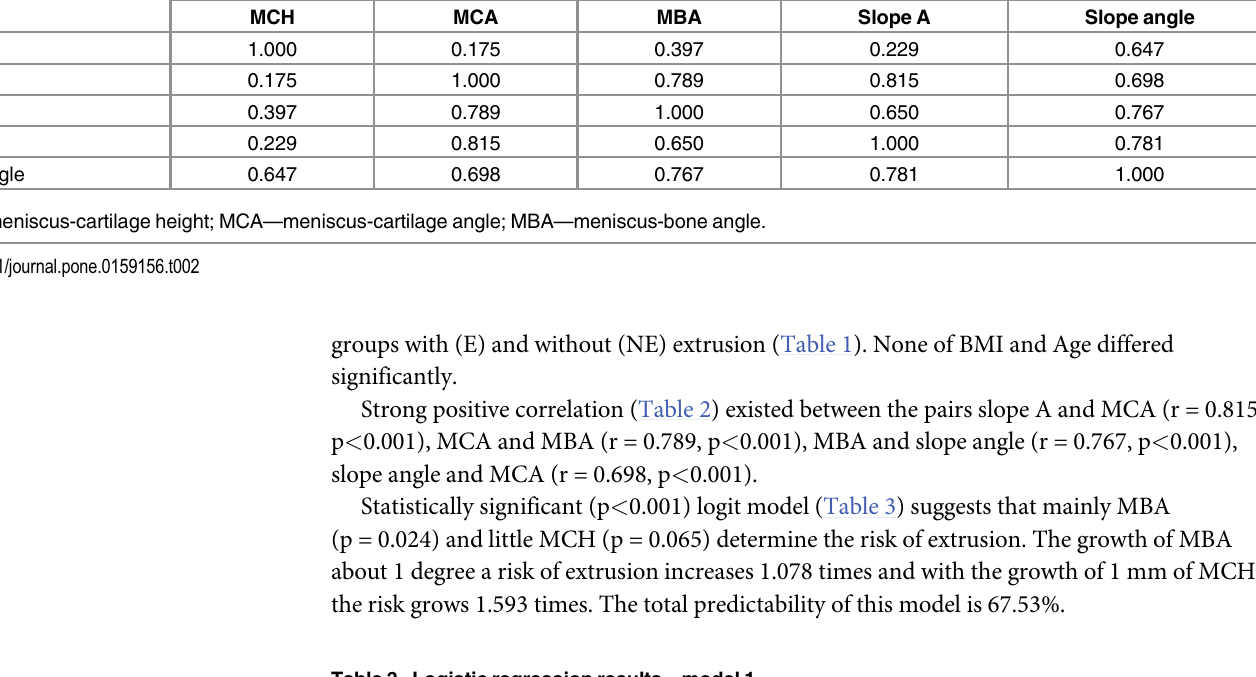
Table 2. Corelation Coeficients matrix for MCH, MCA, MBA, Slope A and Slope angle. Variable